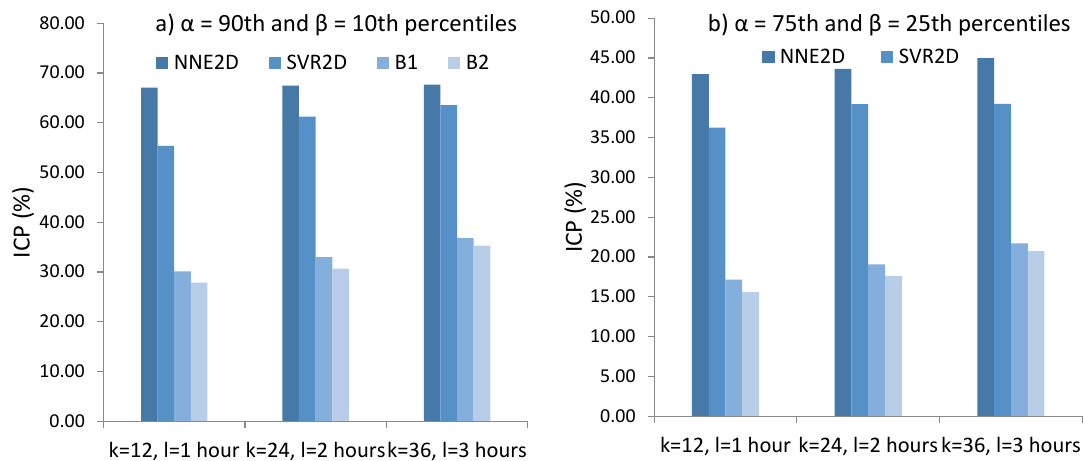
Figure 8. Comparison of ICP for all methods: ( a ) α = 90th and β = 10th percentiles, ( b ) α = 75th and β = 25th percentiles